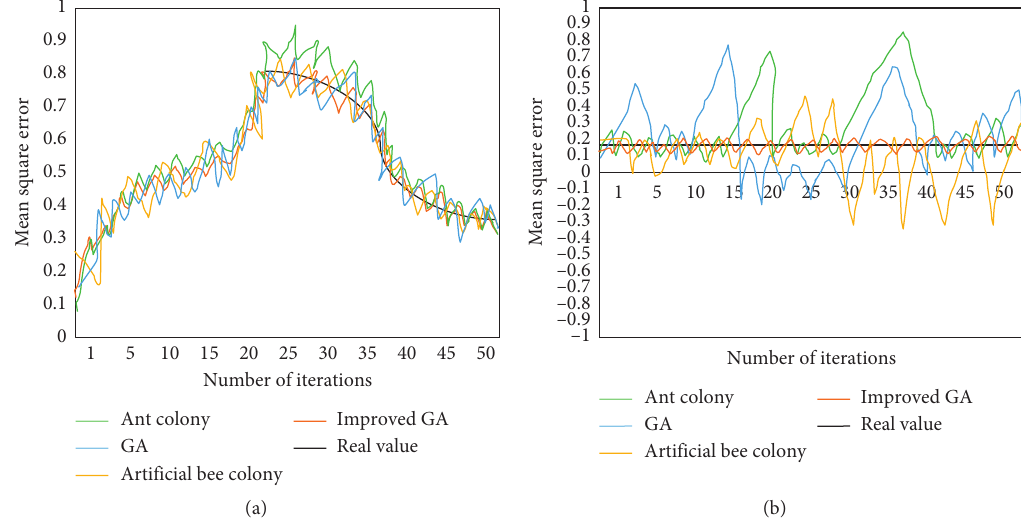
Figure 6: The prediction results and absolute error results of different optimization algorithms. (a) Predicted and true values. (b) Forecast absolute error and mean absolute